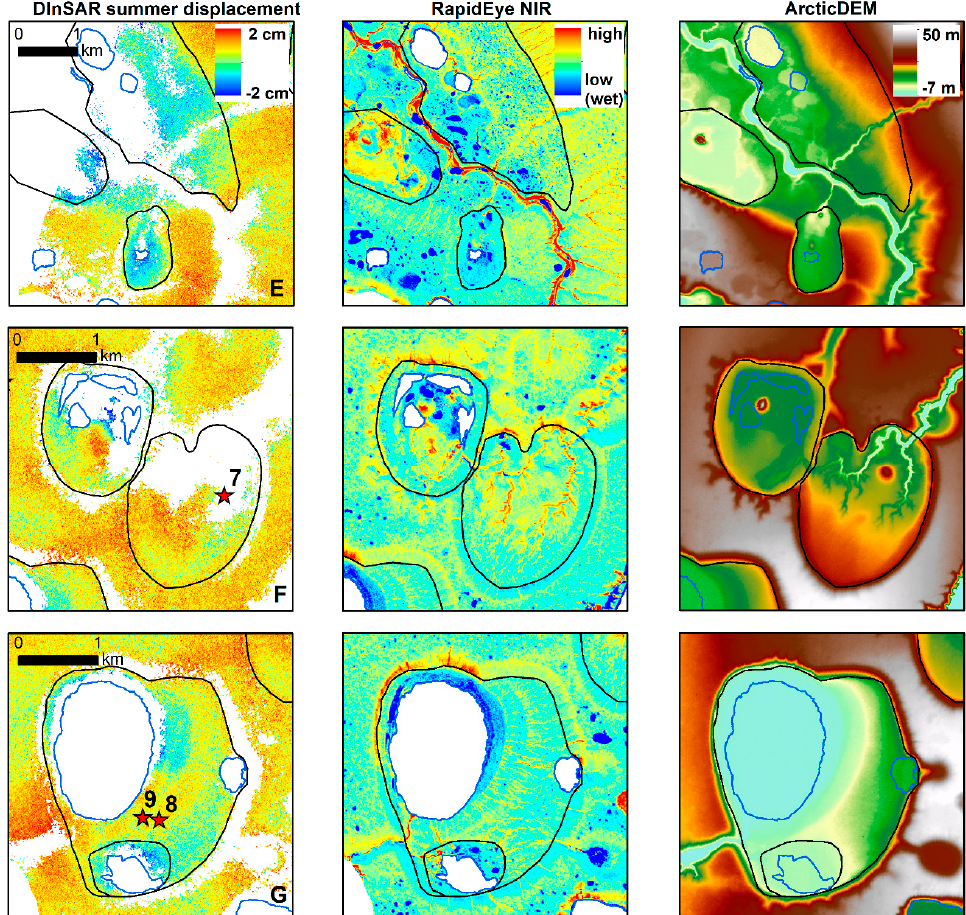
Figure 8. Local comparisons of subsets of DInSAR displacement maps, NIR TOA reflectance and surface elevation over thermokarst basins. Left column : DInSAR cumulative displacement map, masked in areas of low coherence, areas outside of the studied island, or outside of TSX repeat-pass coverage. Middle column : RapidEye optical image, band 5 (NIR TOA), August 2010, reflecting the relative wetness of the surface with low NIR TOA values. Large waterbodies were clipped out. Right column : subset of ArcticDEM, showing the local topography. Thermokarst basins are delineated manually in solid black. Relatively large lakes are delineated manually in solid blue. Location of the lettered boxes can be found in Figure 6. Profiles 1, 2, and 3 in B, C, and D are shown in Figure 9. In situ measurements in the basins are shown as red stars in F and